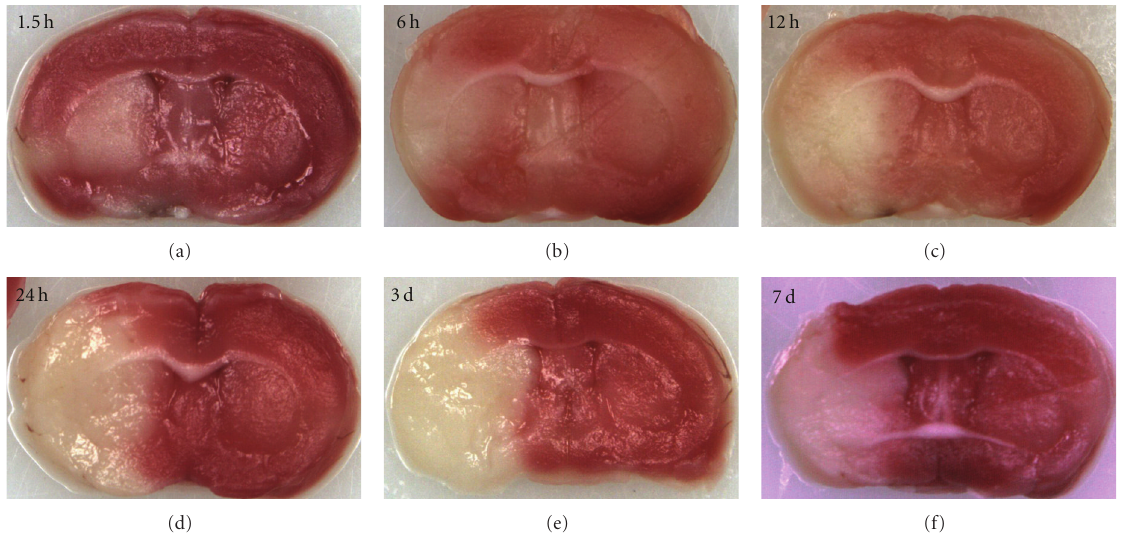
Figure 3: Evolution of infarct in mouse brain after 90-minute